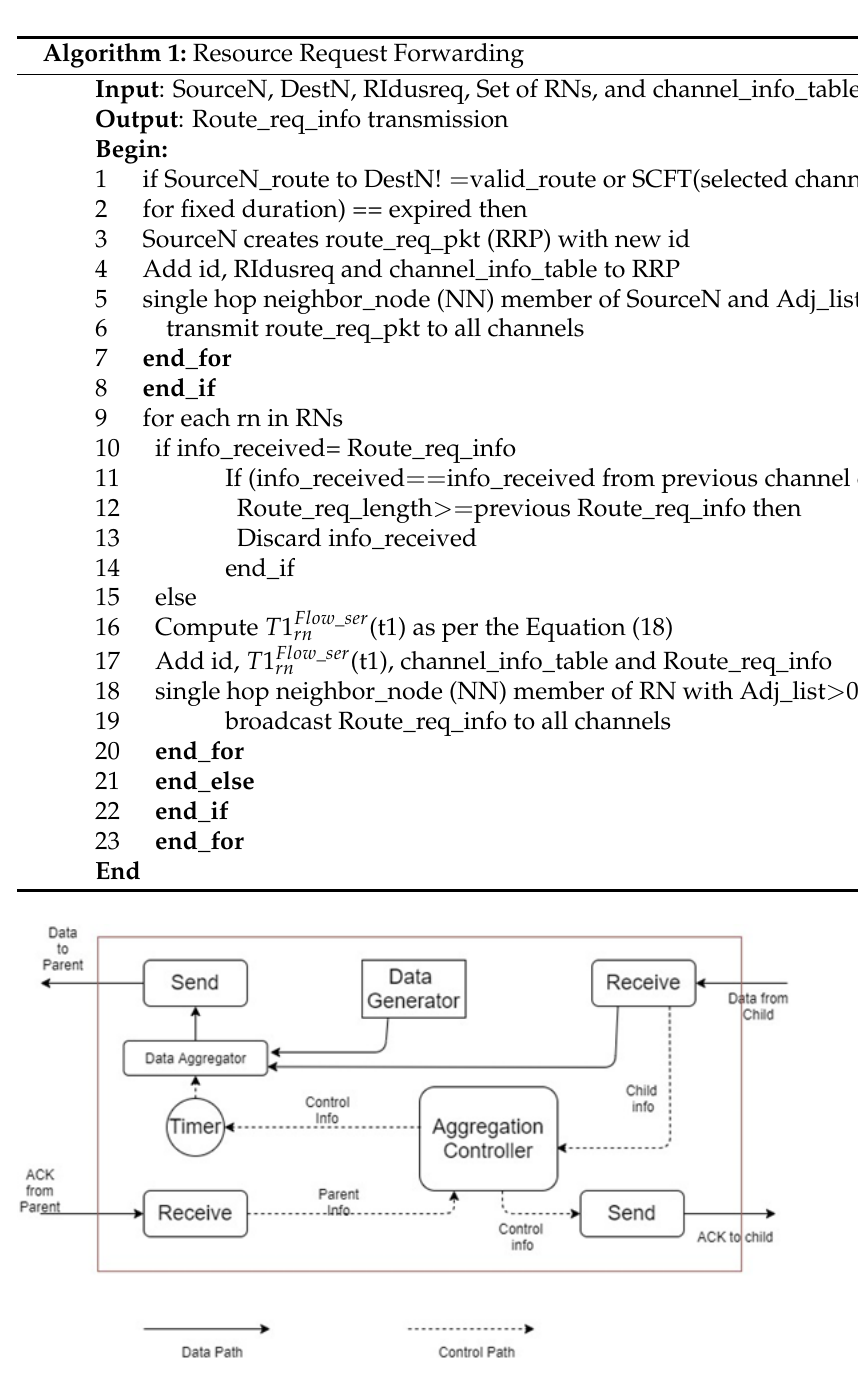
Figure 1. Design overview of the routing